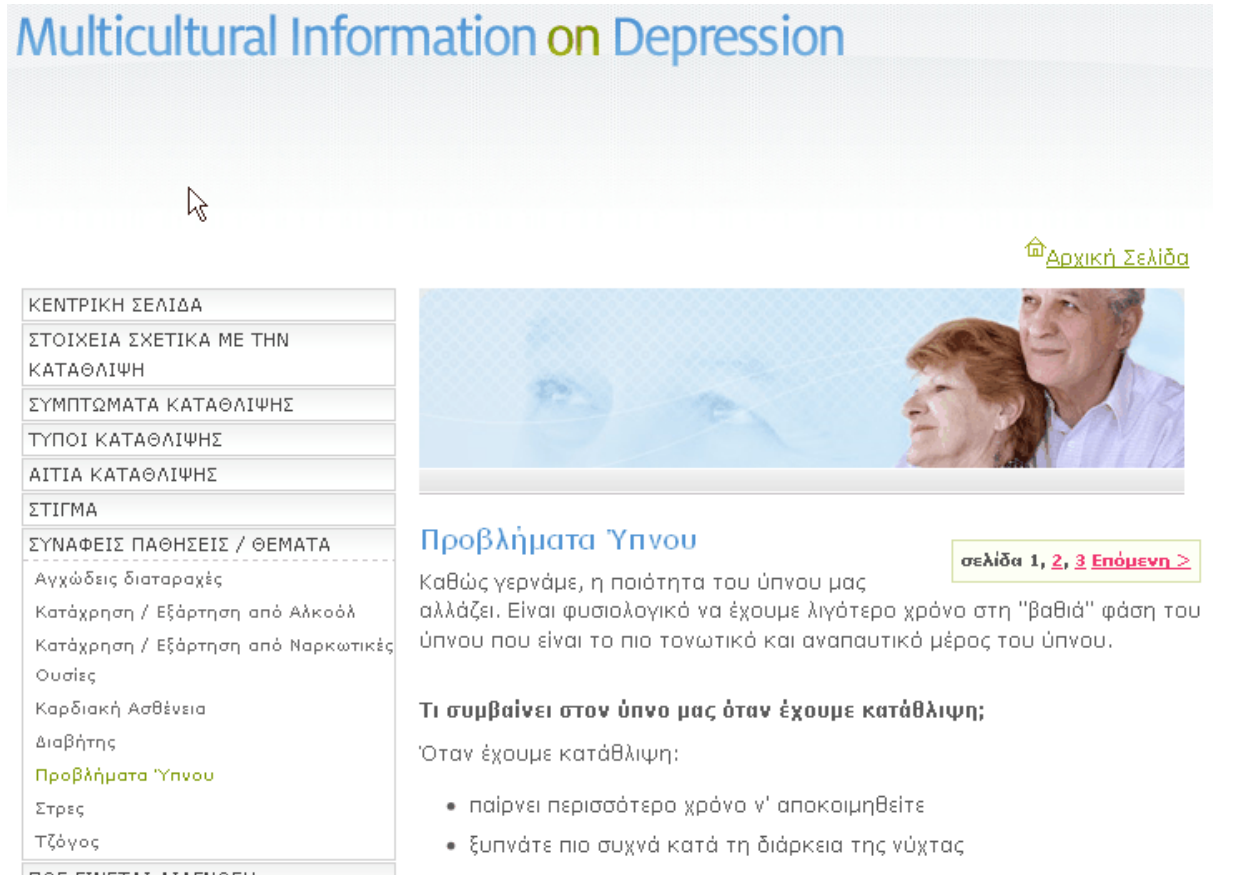
Figure 3. Screenshot of the MIDonline website in